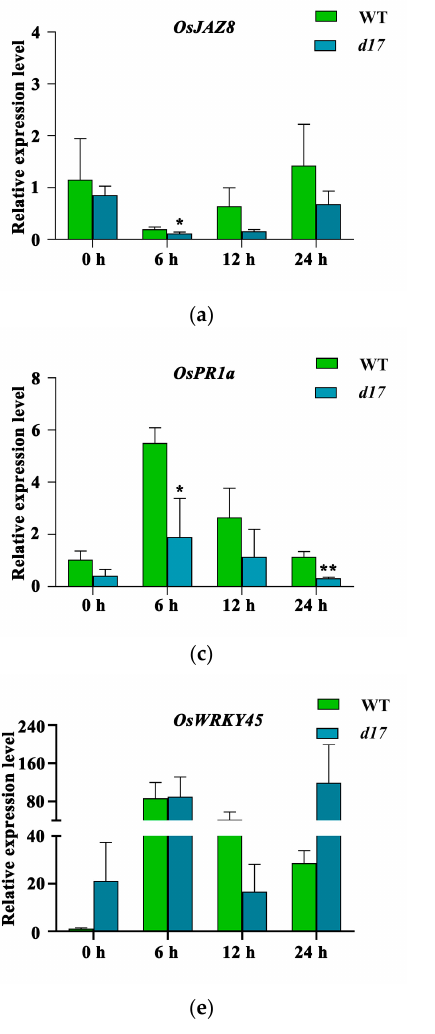
Figure 5. Changes in levels of expression of insect-resistant genes in the WT and d17 plants following exposure to WBPHs for 0 h, 6 h, 12 h and 24 h. (a) The relative expression of OsJAZ8. (b) The relative expression of OsJAMyb. (c) The relative expression of OsPR1a. (d) The relative expression of OsPR10a. (e) The relative expression of OsWRKY45. (f) The relative expression of OsWRKY62. Average (±SD) values from three biological replicates. Signi fi cant di ff erences were determined using Student’s t-test for dependent samples, * p < 0.05, ** p < 0.01.